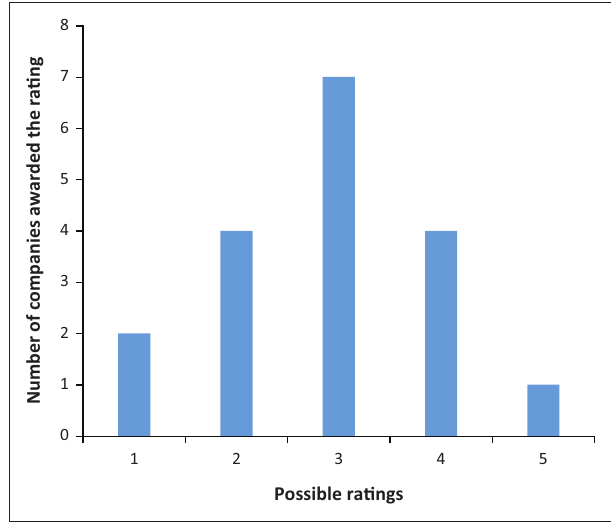
FIGURE 5: Analysis of score per ratings